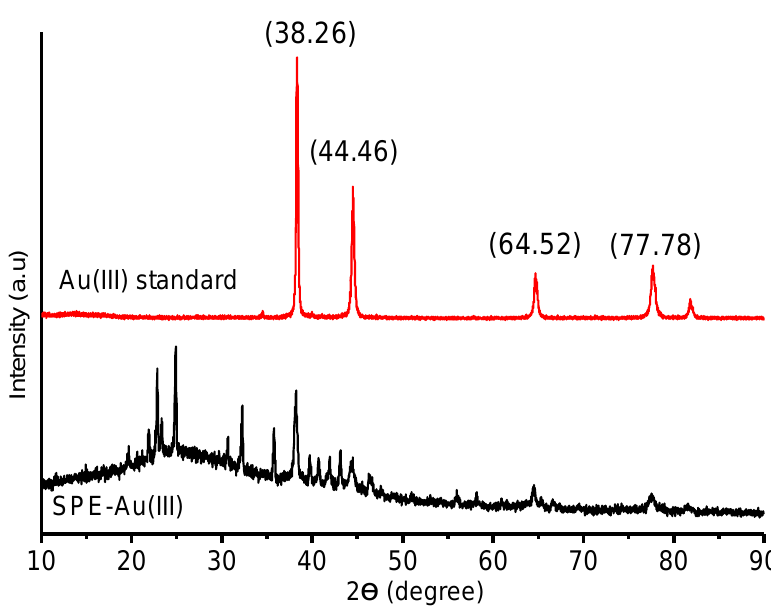
Figure 6. XRD analysis of SPE-Au(III).